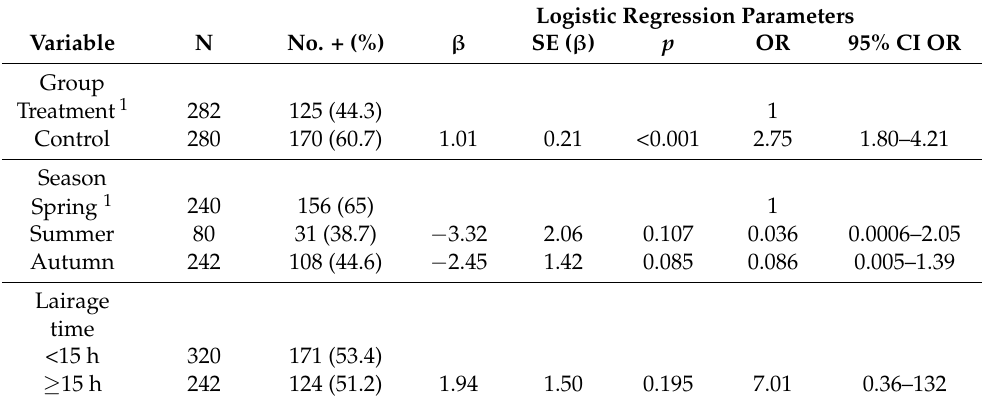
Table 4. Results of the random-effects logistic regression analysis to assess the relationship between water treatment with the esterified formic acid and Salmonella shedding after adjusting by season and time at